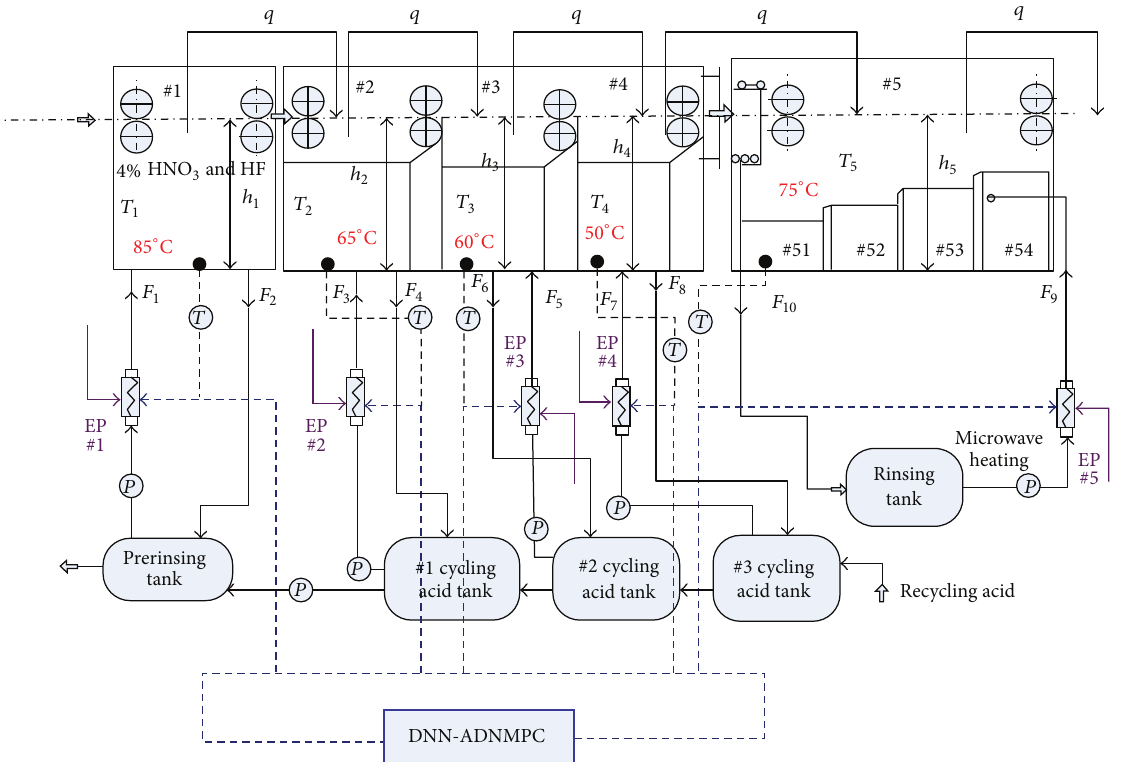
Figure 1: Simplified flow diagram of titanium pickling process control